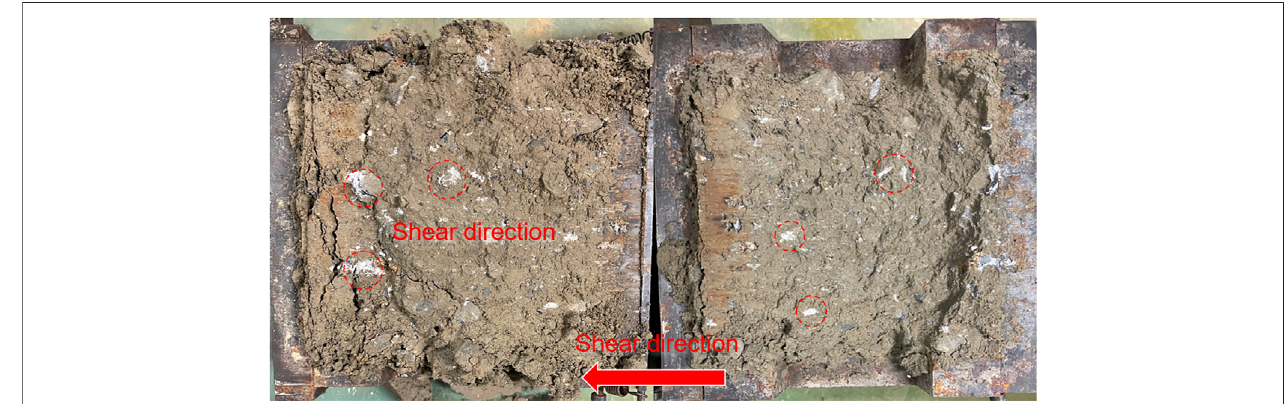
FIGURE 7 | The failure surface of the sample.